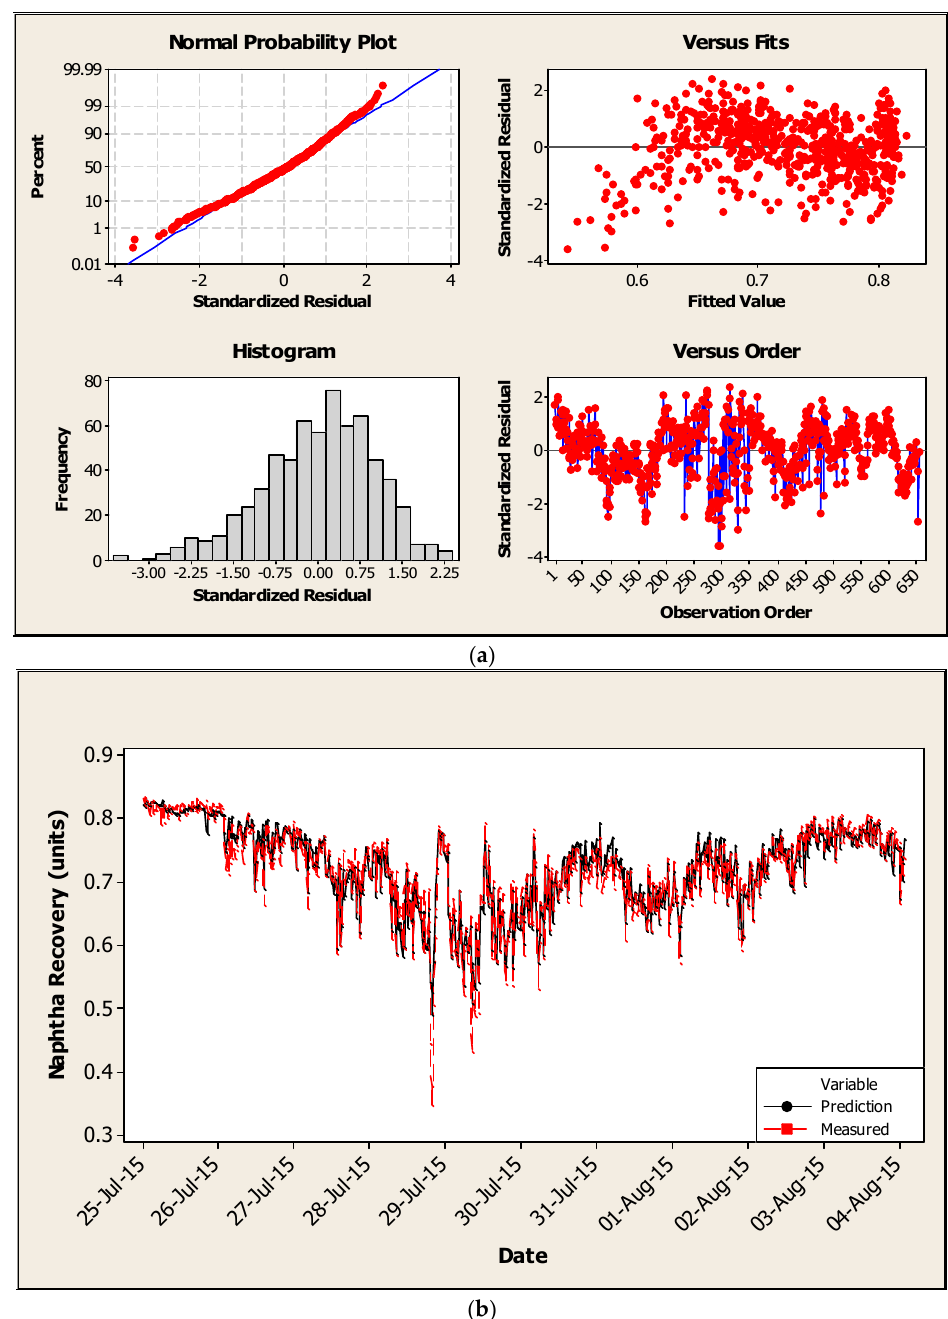
Figure 4. ( a ) Statistical modelling results for OP1 (residuals developed using training data); ( b ) Statistical modelling results for OP1 comparing measured versus predicted NR using testing data.